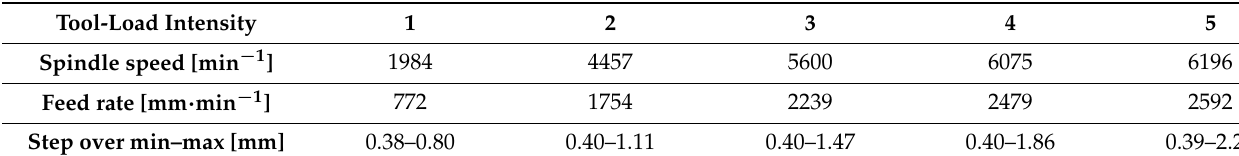
Table 3. Cutting parameters.